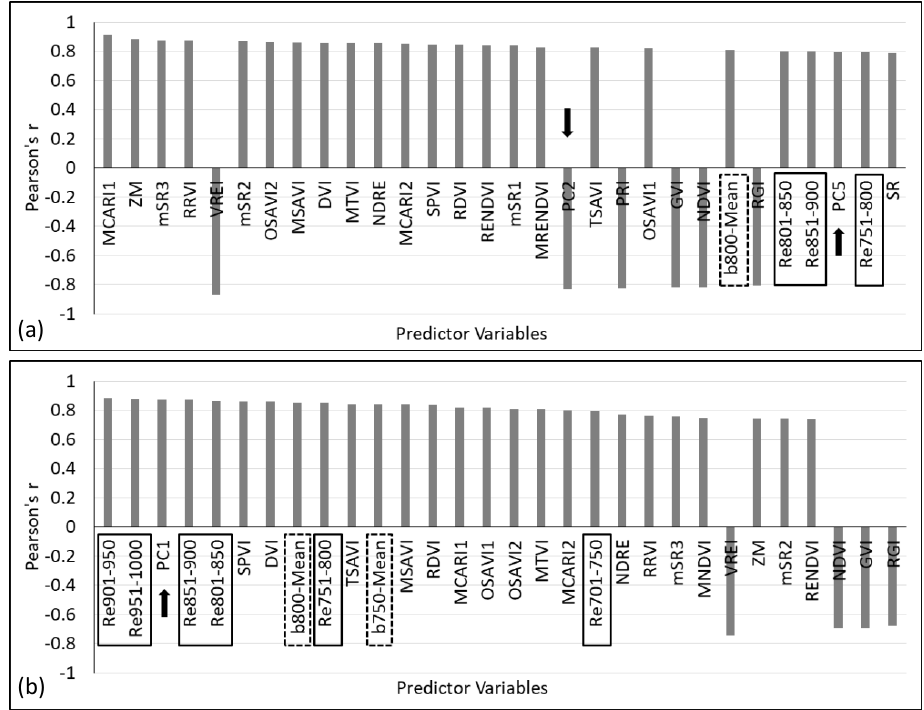
Figure 5. Top 30 strongest correlations between predictor variables and canopy chlorophyll contents. ( a ) For image acquired in June. ( b ) For image acquired in August. Reflectance variables are highlighted with solid rectangles, textural variables with dashed rectangles, and principal components (PCs) with arrows. Each reflectance labelled in the figure is a group of neighboring reflectance variables that are highly correlated with each other, such as the Re801 – 850 includes reflectance from 801 to 850 nm.